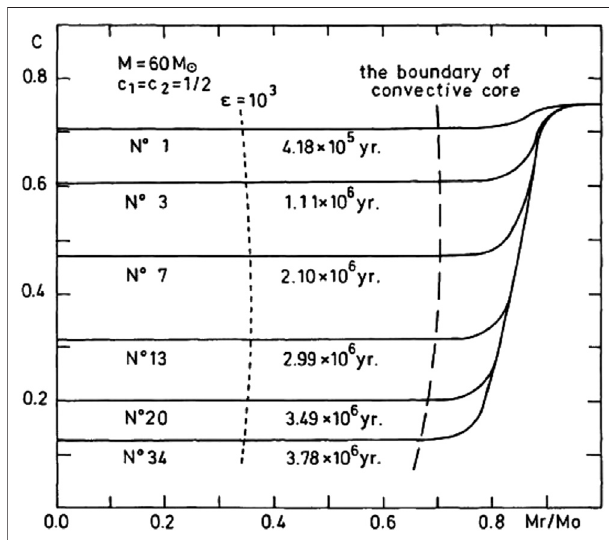
FIGURE 7 | Outlines of hydrogen content at various evolution ages for a 60M ⊙ star. The dashed line is the boundary of the convectively unstable core, and the dotted line indicates the location of the nuclear energygeneration rate ε (cid:1) 1000erg / s(Xiong, 1986).